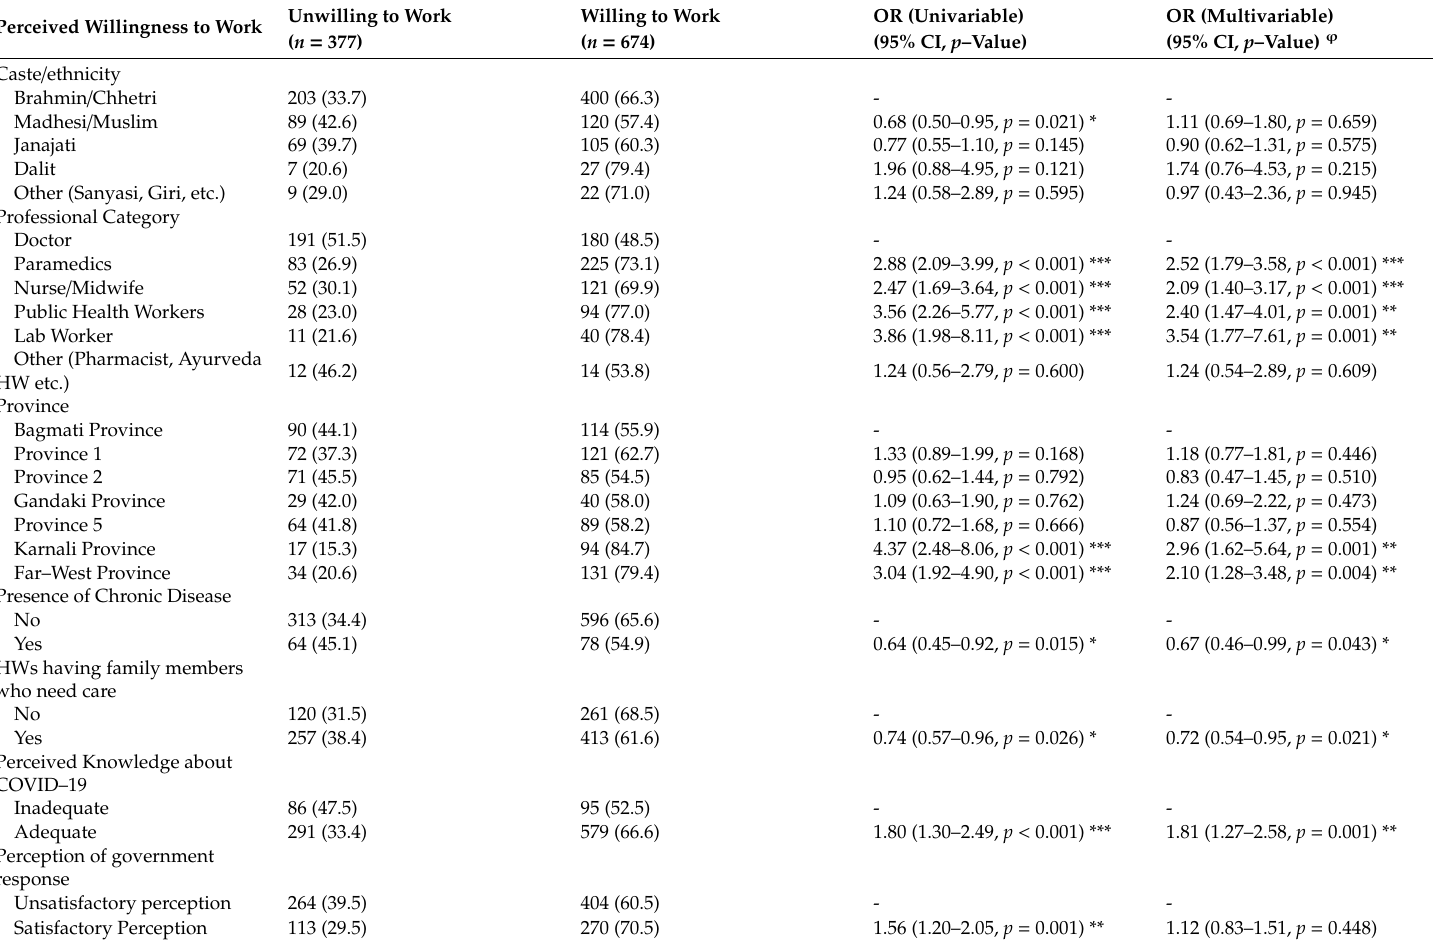
Table 4. Factors associated with self-reported willingness to work during the COVID-19